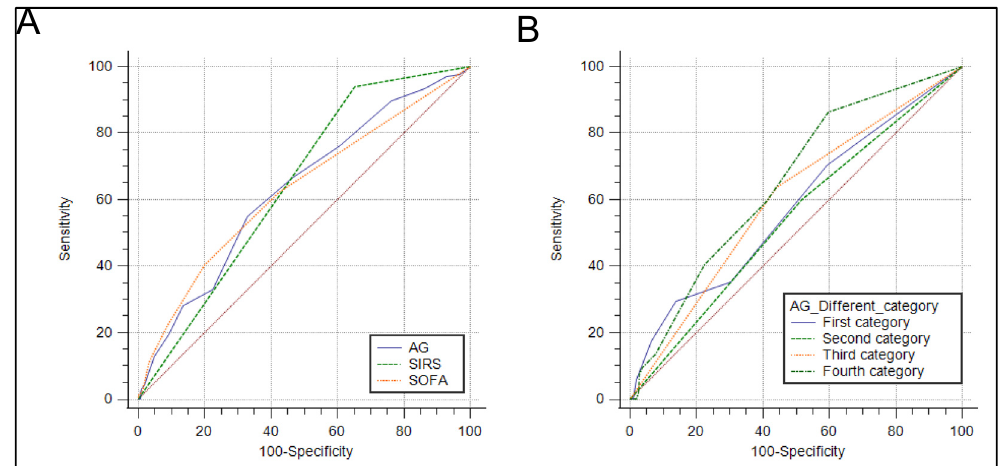
Figure 4. Receiver operating characteristic curves for the prediction of the in-hospital mortality in critically ill patients with ischemic stroke. ( A ) The ability of the SIRS score, SOFA score, and AG to predict in-hospital mortality. ( B ) The ability of different AG category to predict in-hospital mortality. AG: anion gap; SIRS: systemic inflammatory response syndrome; SOFA: sequential organ failure assessment